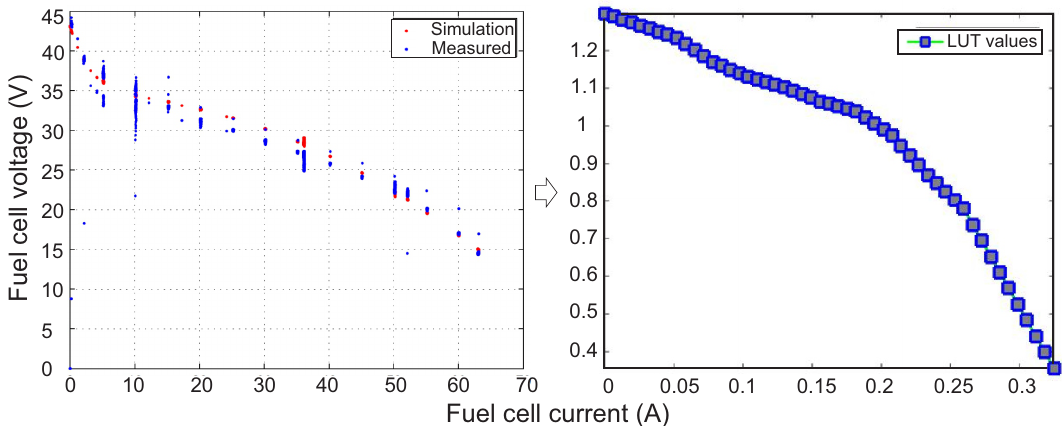
Figure 3. Extrapolation of V-I characteristics.